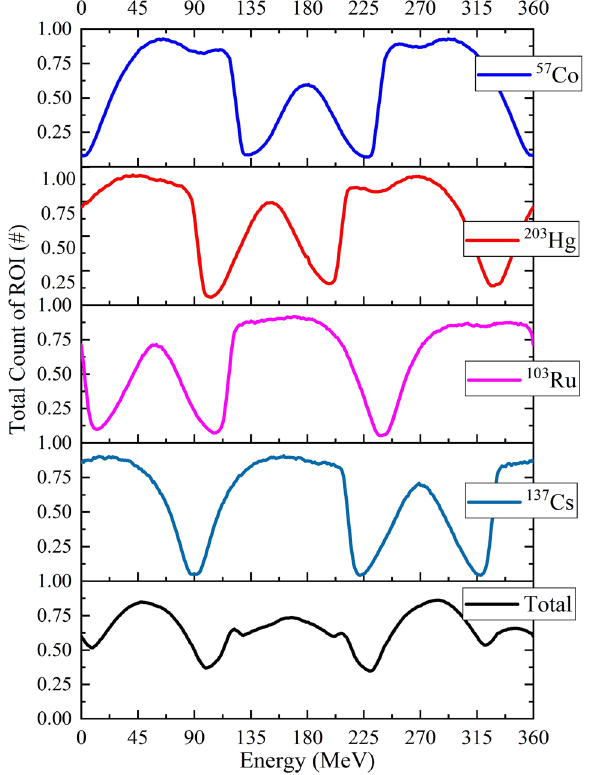
Figure 8. Total count of ROI (per particle) and total count versus orientation of detector in simultaneously presence of 57 Co, 203 Hg, 103 Ru and 137 Cs in positions of